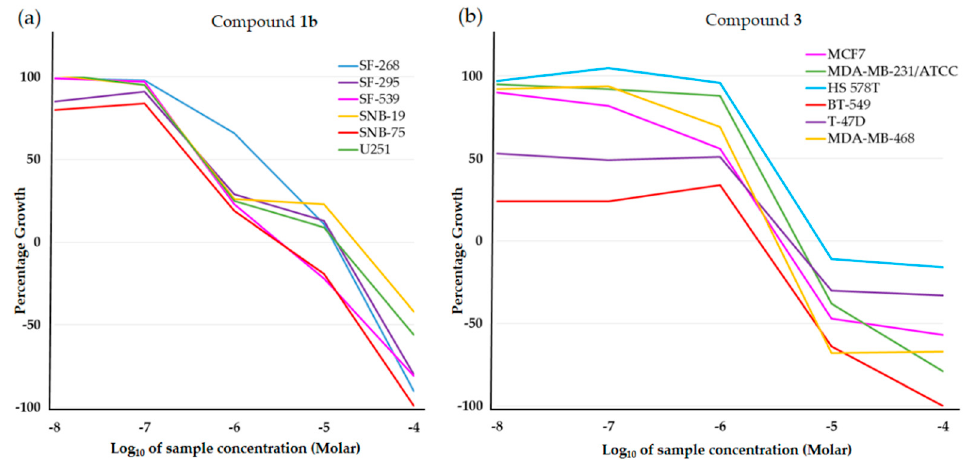
Figure 2. Dose response curves at NCI fixed protocol: ( a ) for compound 1b on the indicated central nervous system (CNS) cancer cell lines, and ( b ) for compound 3 on the indicated breast cancer cell lines. The curves were obtained at five concentrations (log dilutions from 10 –4 to 10 –8 M). The concentrations of each compound, which inhibited 50% of cancer cell growth (GI 50 ), were deduced and are the values reported in Table 1.